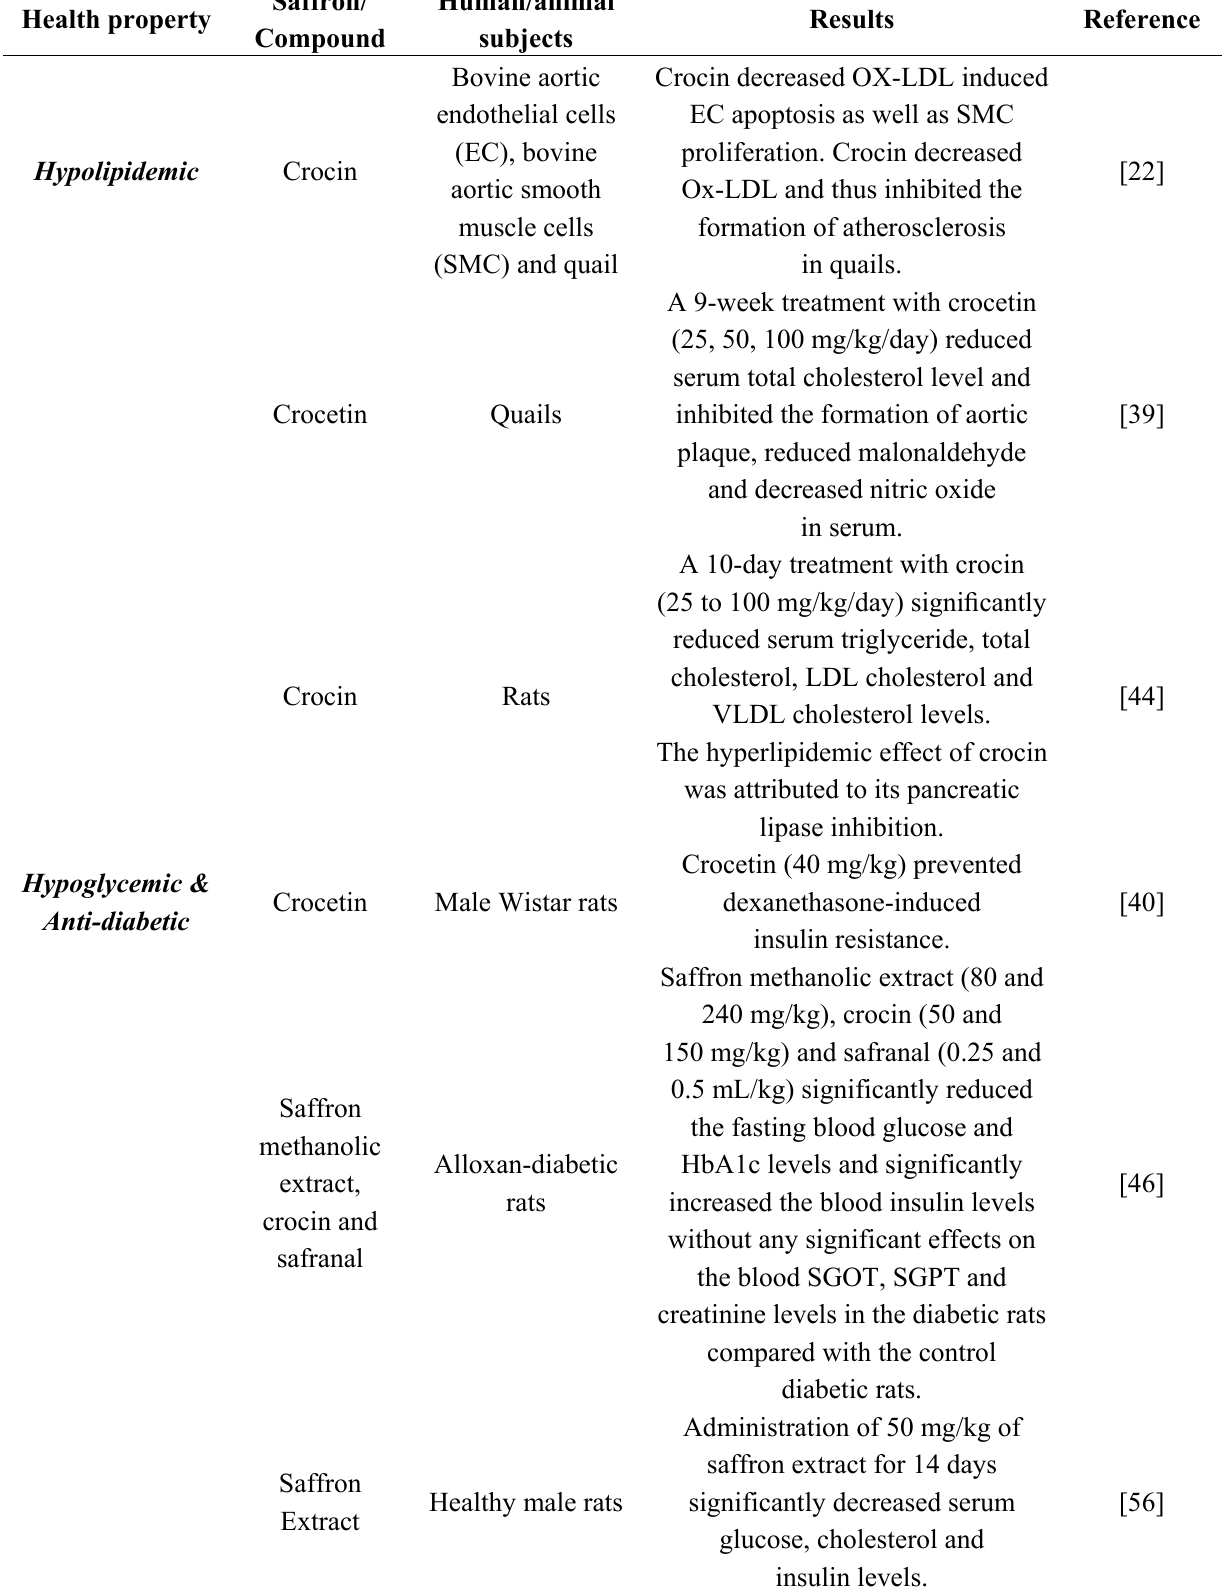
Table 1. Major biological properties of saffron attributed to potential anti-obesity